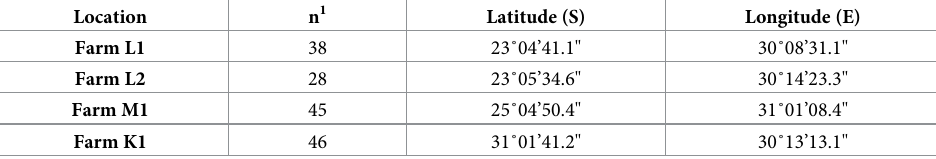
Table 1. Sampling locations where B . distincta was collected between October 2017 to March 2020 in South Africa provinces.